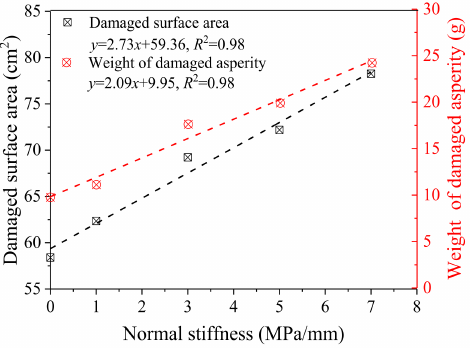
Figure 7. Damaged surface area and weight of damaged asperity of the joint surface under different normal stiffness